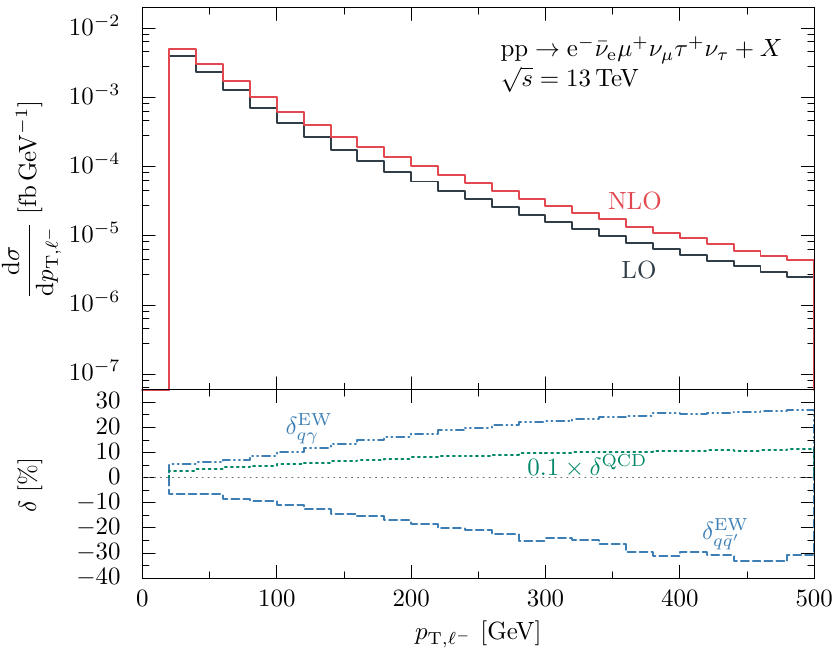
Figure 8. Di(cid:11)erential distribution in the transverse momentum p lepton in e (cid:0) (cid:22) (cid:23) e (cid:22) + (cid:23) (cid:22) (cid:28) + (cid:23) (cid:28) + X